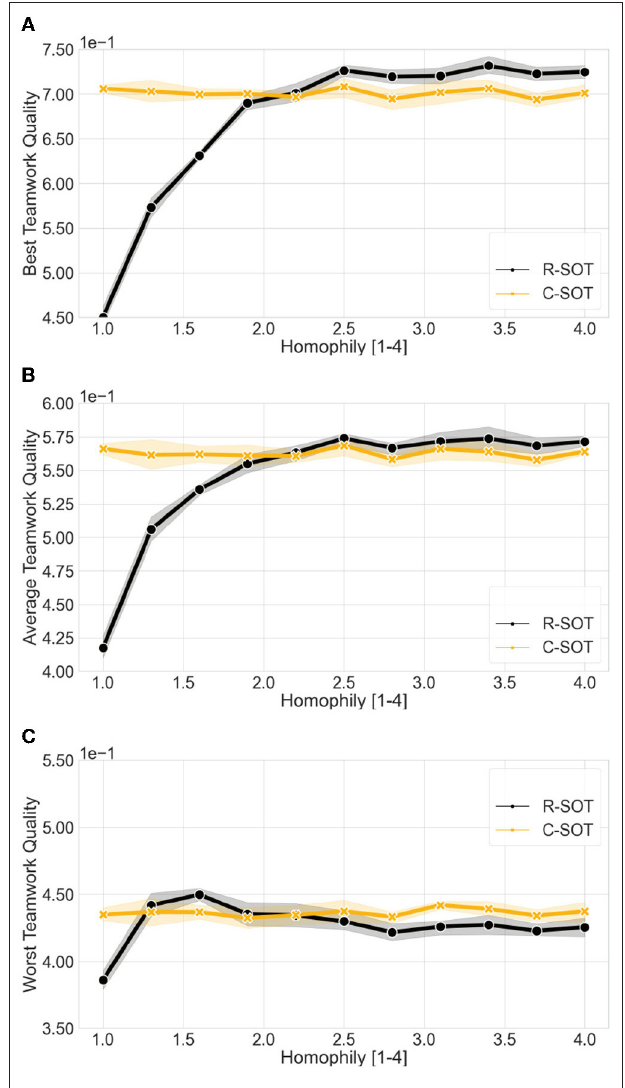
FIGURE 5 | Comparison of the best and worst teamwork quality between bottom-up models (C-SOT and R-SOT) with different homophily thresholds. The x axes show the workers’ different homophily levels ( θ ∈ [1,4]) where the lowest θ value represents the highest possible tolerance toward differences between workers’ attributes, and the highest θ value the lowest tolerance. Even though the best teamwork quality for the two models improves as the homophily threshold grows, particularly with thresholds θ > 2, the worst teamwork quality remains overall stable with the exception of R-SOT peaking around a threshold θ ≈ 1.5 before settling around a worst teamwork quality of 0.42 with θ > 2.5. (A) Best teamwork quality for C-SOT and R-SOT with different homophily (preference of working with similar teammates) thresholds ( θ ∈ [1,4]) . (B) Average teamwork quality for C-SOT and R-SOT with different homophily thresholds ( θ ∈ [1,4]) . (C) Worst teamwork quality for C-SOT and R-SOT with different homophily (preference of working with similar teammates) thresholds ( θ ∈ [1,4])